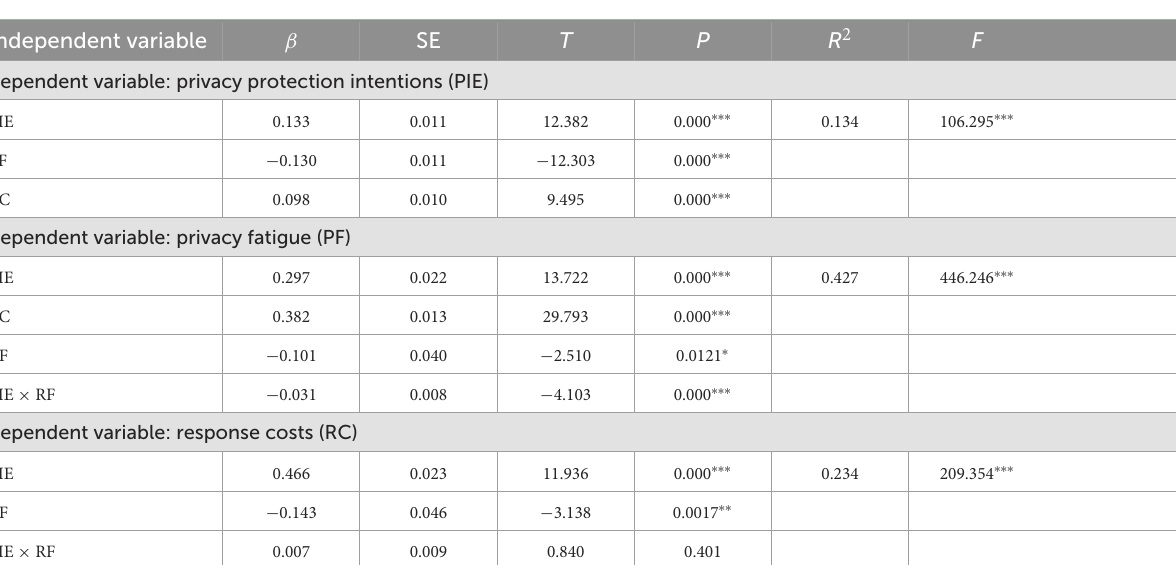
TABLE 4 Multiple regression results of the moderated mediation model.